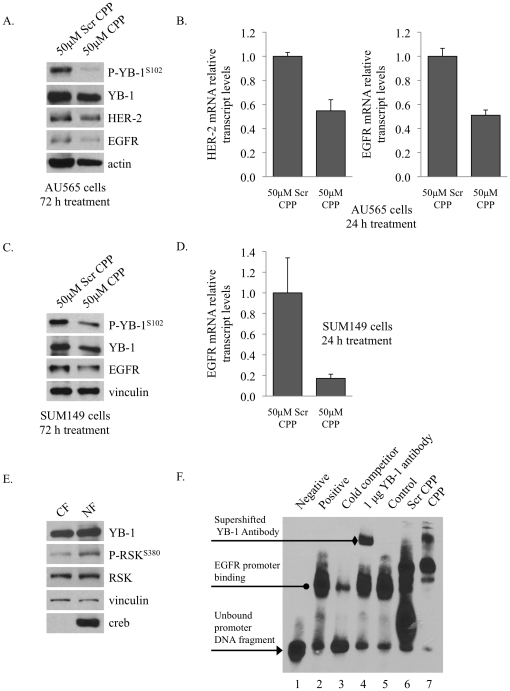
The CPP impaired YB-1s transcriptional activity against HER-2 and EGFR.
A. Treating AU565 cells with the CPP for 72 h reduced P-YB-1S102 and that correlated with down-regulation of its target gene products EGFR and HER-2. B. HER-2 and EGFR transcripts are also markedly decreased in AU565 cells after 24 h CPP treatment based on qRT-PCR. * P<0.01. C. Likewise, the CPP decreased P-YB-1S102 and thus EGFR in SUM149 cells after 72 h. D. EGFR transcript levels were also decreased in the SUM149 cells following 24 h peptide treatment. * P<0.01. E. Nuclear extracts were prepared from SUM149 cells. A western blot confirmed that the nuclear fraction (NF) contained the components (YB-1 and RSK) necessary for the gel shift analysis. CF =  cytoplasmic fraction. F. Nuclear proteins from breast cancer cells, SUM149, bind to the EGFR promoter DNA (lane 2) compared to the unbound biotin labeled oligonucleotide DNA (lane 1). Binding was specific because cold competitive oligonucleotides to the same sequence diminished binding (lane 3). The transcription factor responsible for binding was YB-1 because introducing 1 µg of YB-1 antibody (lanes 4) caused a super-shift in the binding product. YB-1 bound with high affinity in the presence of acetic acid control (lane 5) and 25 µM scrambled peptide (lane 6), whereas incubation with 25 µM of the CPP blocked binding and cause a super-shift (lane 7).